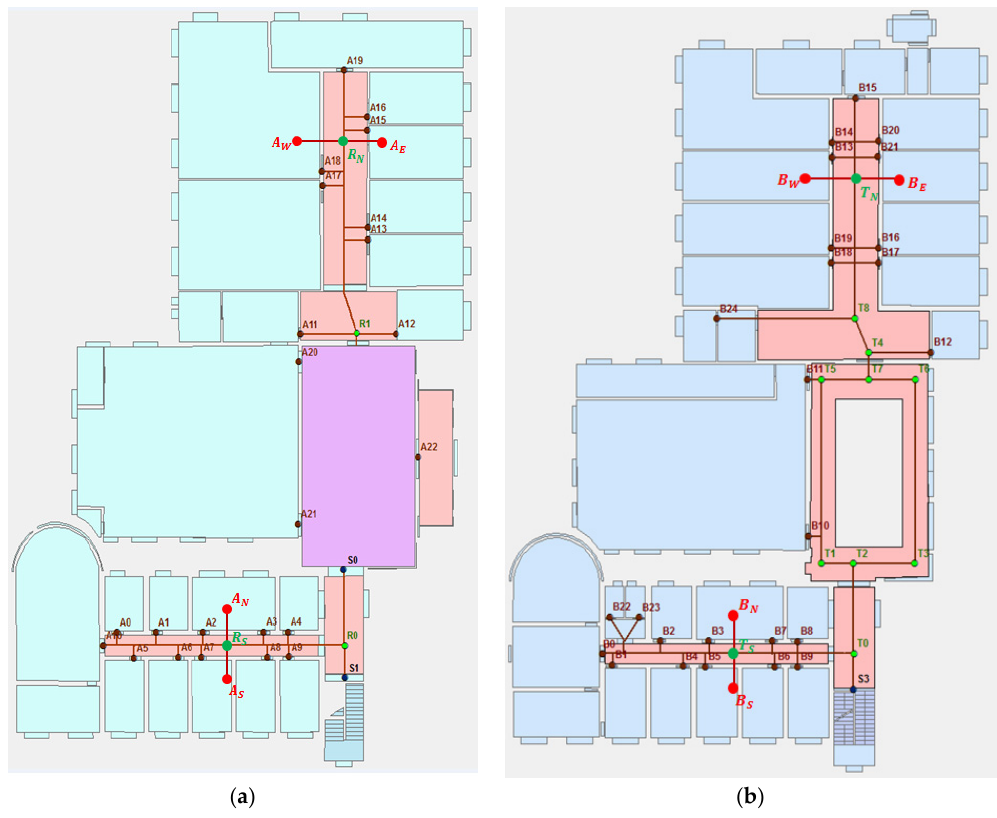
Figure 1. Link-node model of an indoor map [5]. ( a ) The link-node model of the first floor; ( b ) The link-node model of the second floor.